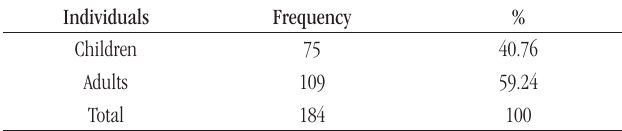
taBLE 1 − Distribution of patients according to age Individuals